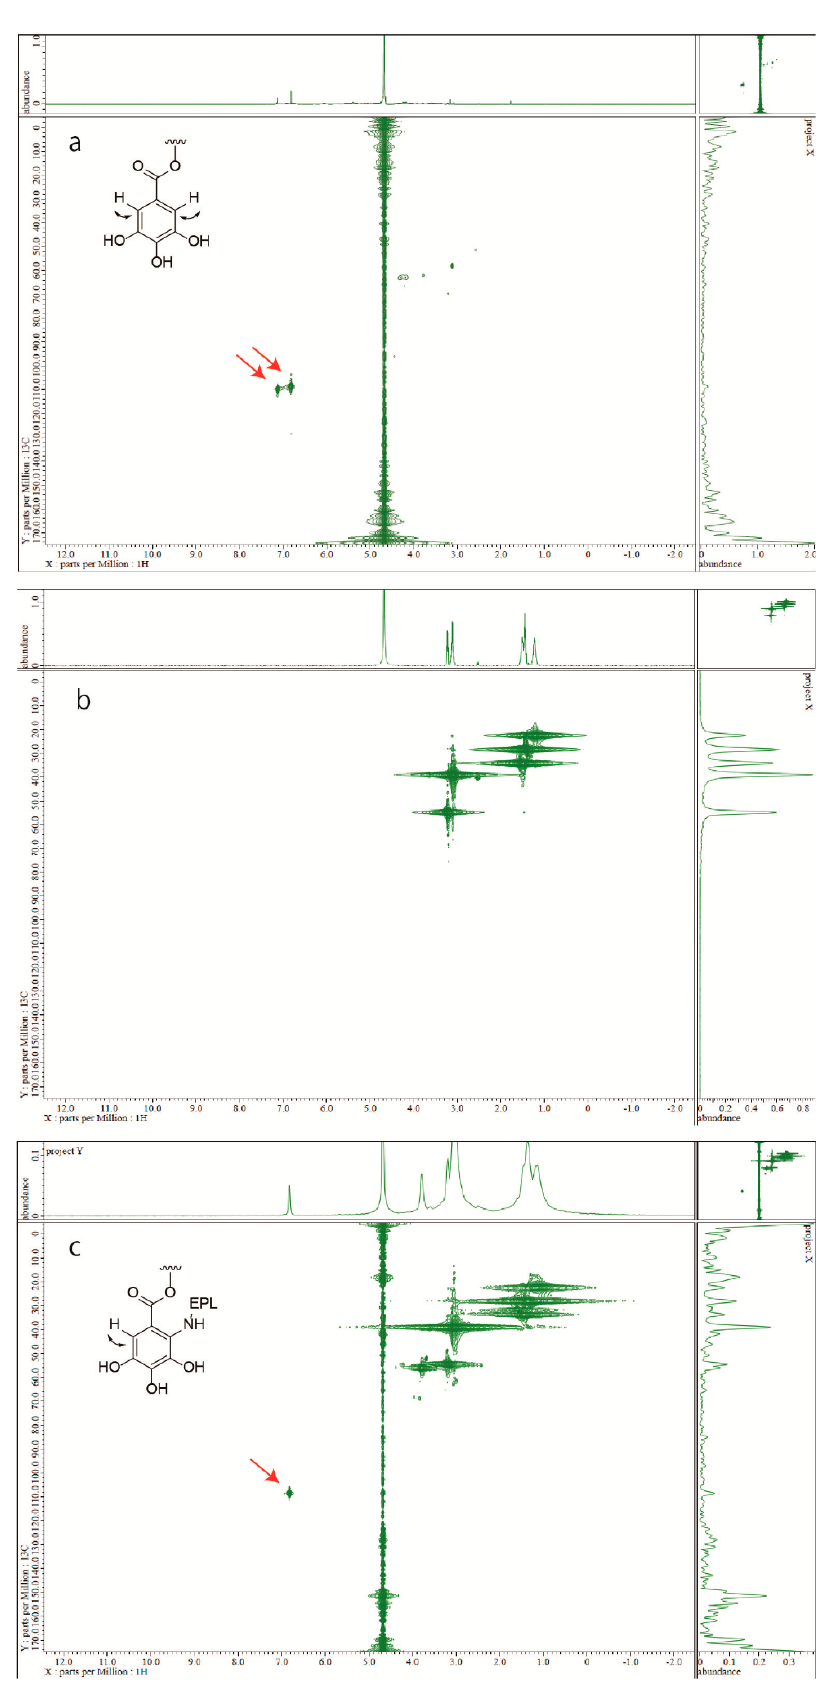
Figure 2. HMQC spectra of tannic acid ( a ), EPL ( b ), and their mixture ( c ).